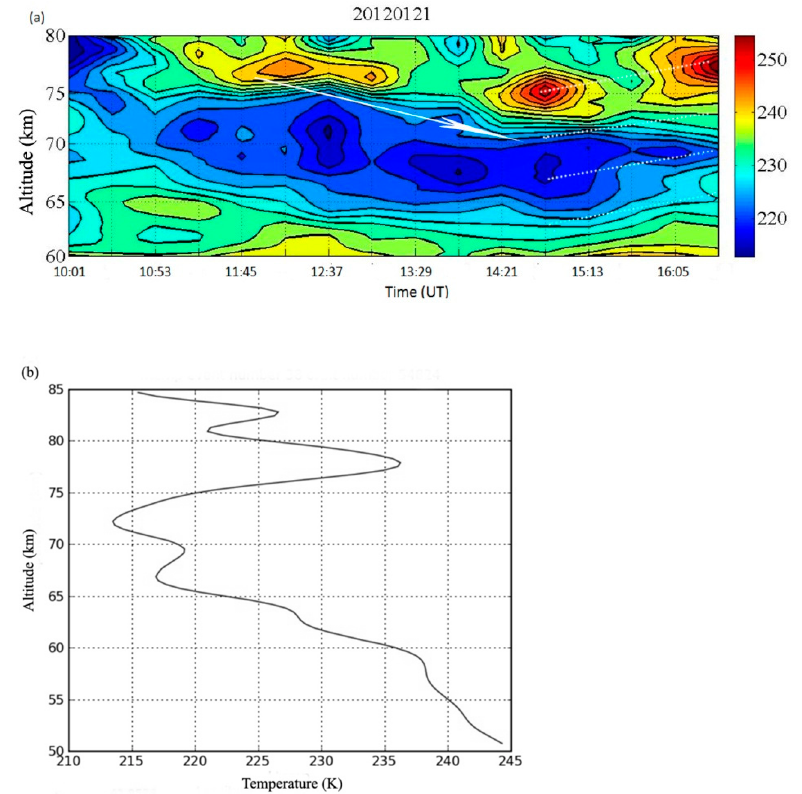
Figure 4. ( a ) MIL case profiles on 21 January 2012; the white arrow indicates the downward propagation tendency and the dashed line indicates the upward propagation tendency of the MILs ( b ). The reference TIMED/SABER data at 41° N, 118.7° E of a vertical resolution at 2 km, solar zenith 155.18, event 38, orbit number 54824.